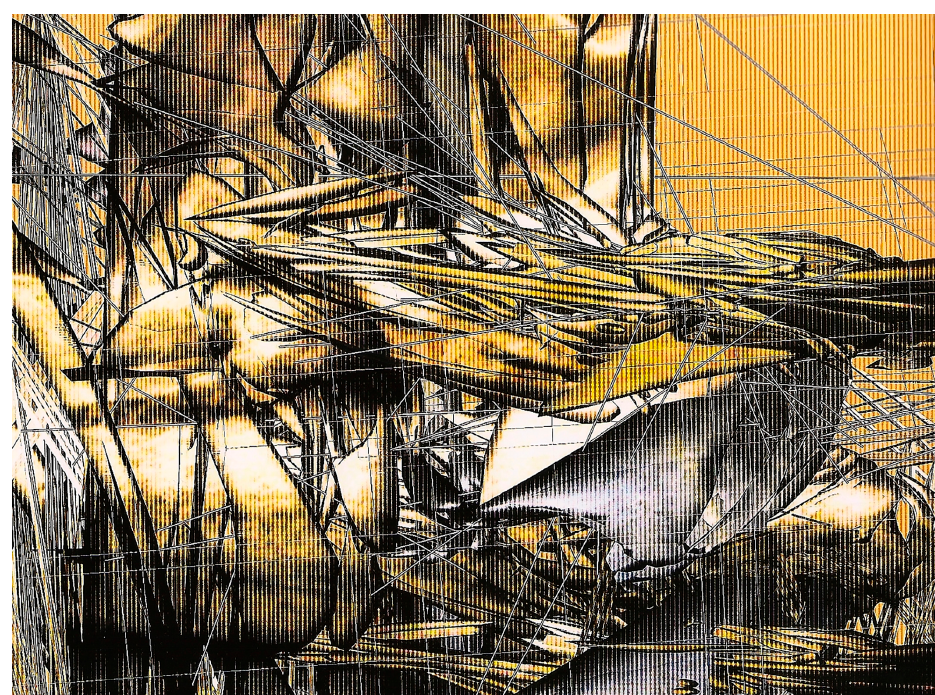
Figure 2. Felix Robbins, Adverting Absurdities ,